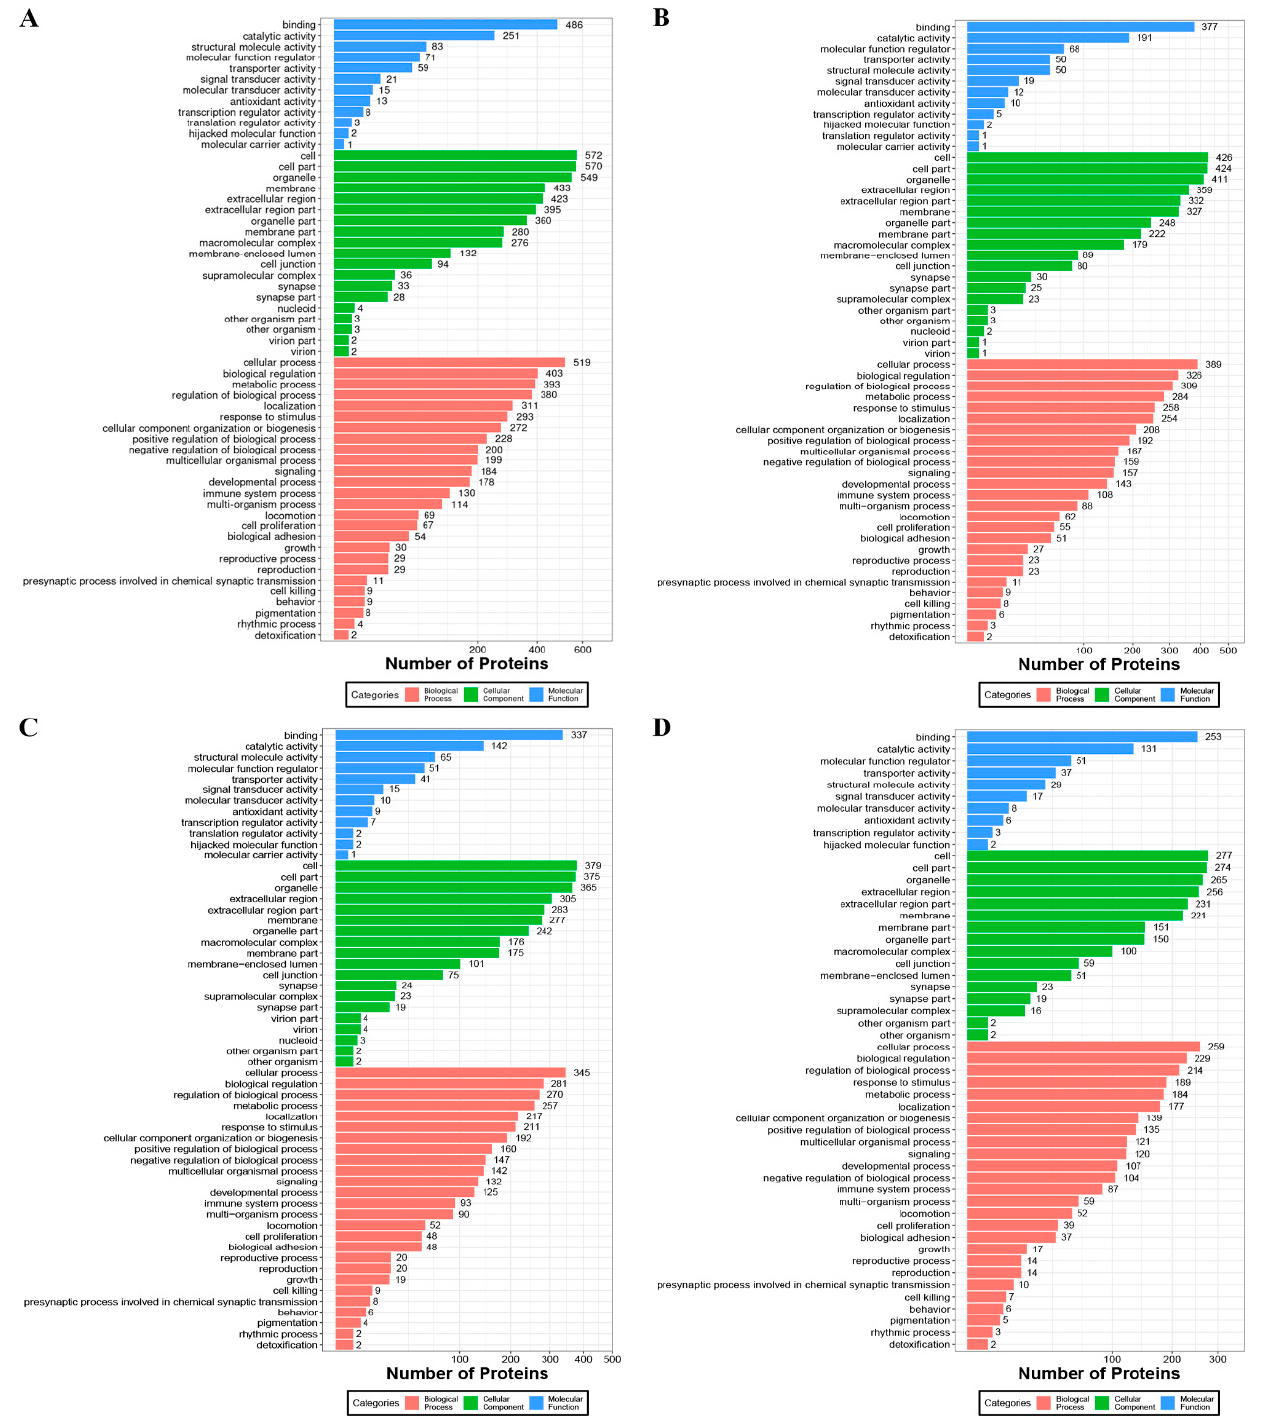
Figure 5. GO analysis of the identified MFGM proteins of raw milk ( A ), spray-dried milk ( B ), ultra-high temperature instant sterilization milk ( C ), and ultra-pasteurized milk ( D ), respectively.